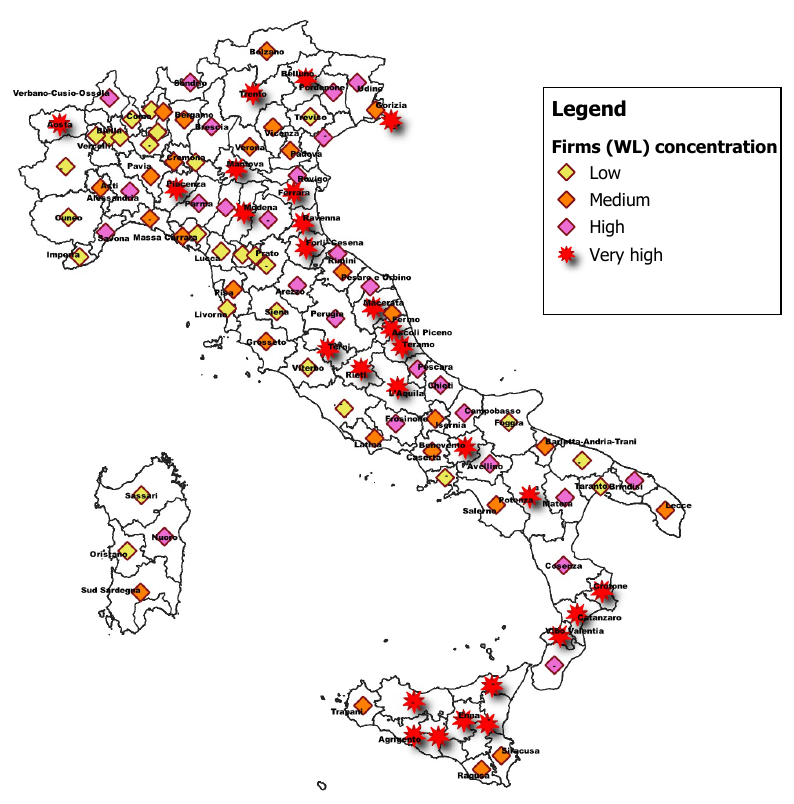
Figure 1. Concentrations of firms (WL). Source: Authors processing of AIDA Bureau Van Dijk and Prefectures